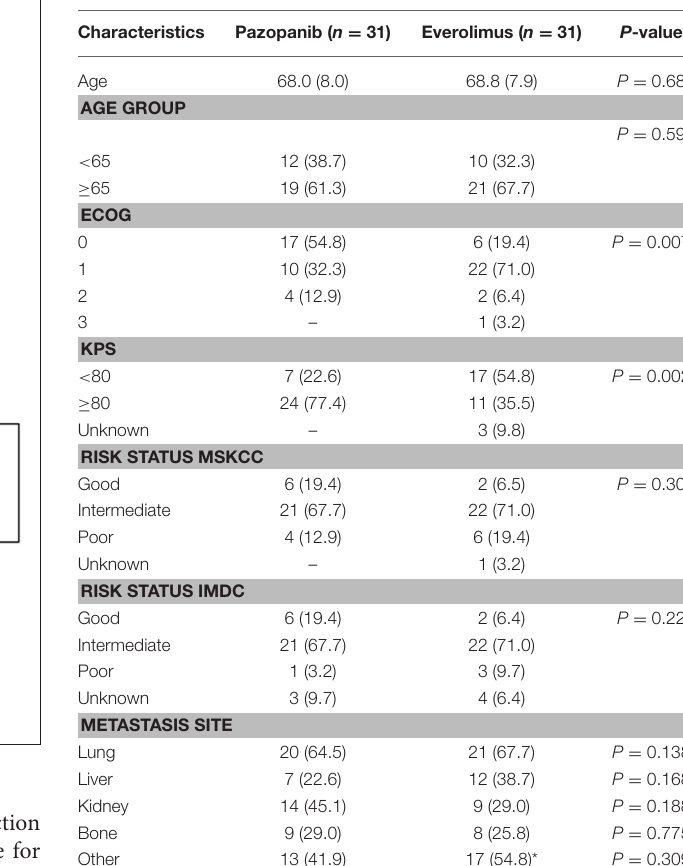
TABLE 1 | Baseline